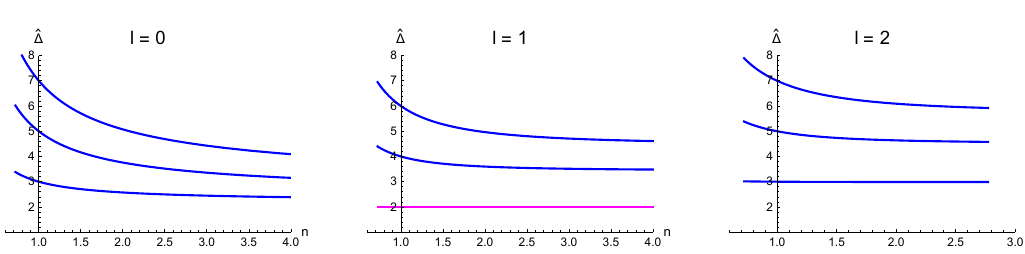
Figure 11 . Plots of scaling dimension the di(cid:11)erent ‘ channels at d = 3. The displacement operator is shown in pink and has a protected scaling dimension. The lowest dimension operator for (cid:12)xed ‘ is \minimal twist" except for ‘ = 0